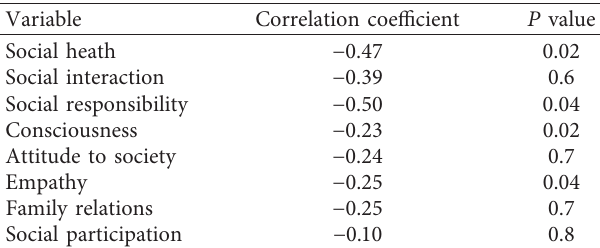
Table 2: The relationship between pH with social health and its